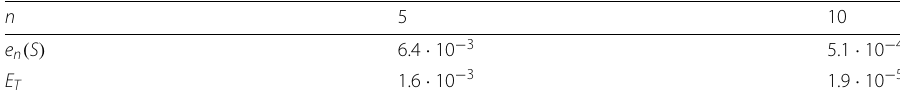
Table 4 Errors e n and E T with the S spline for (20) n